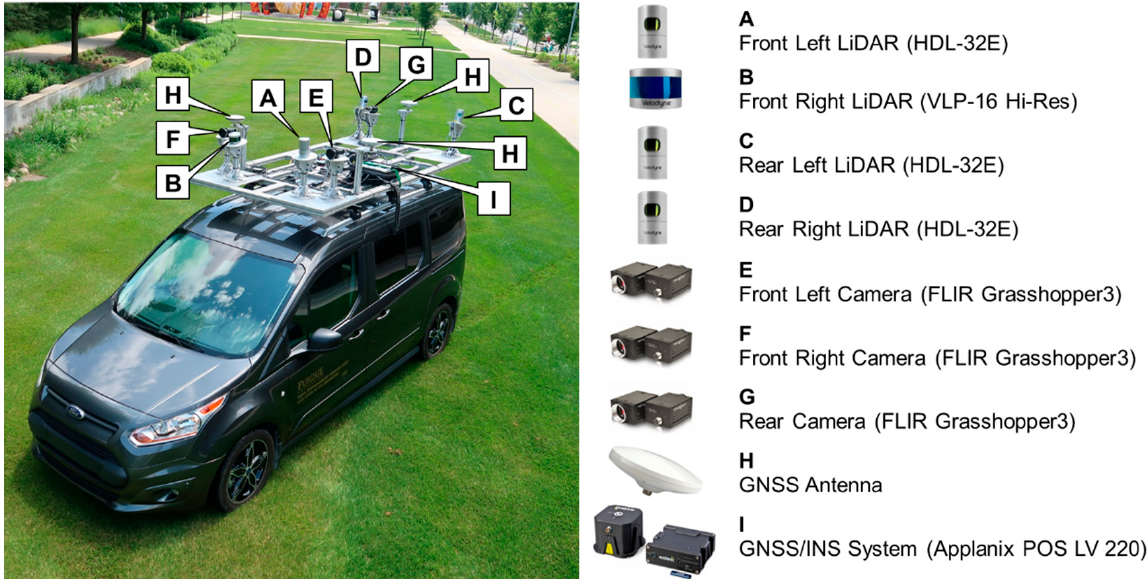
Figure 1. Purdue Wheel-Based Mobile Mapping System, High Accuracy (PWMMS-HA) unit used in this study.